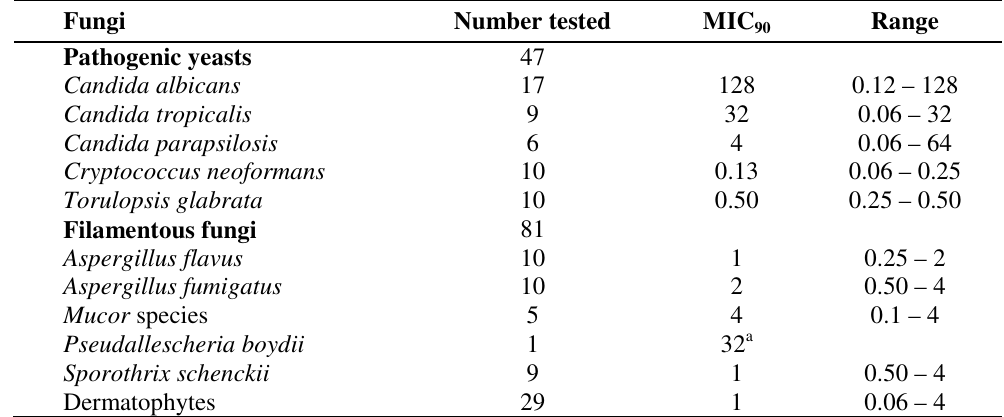
Table 8. In vitro antifungal activity of oxiconazole